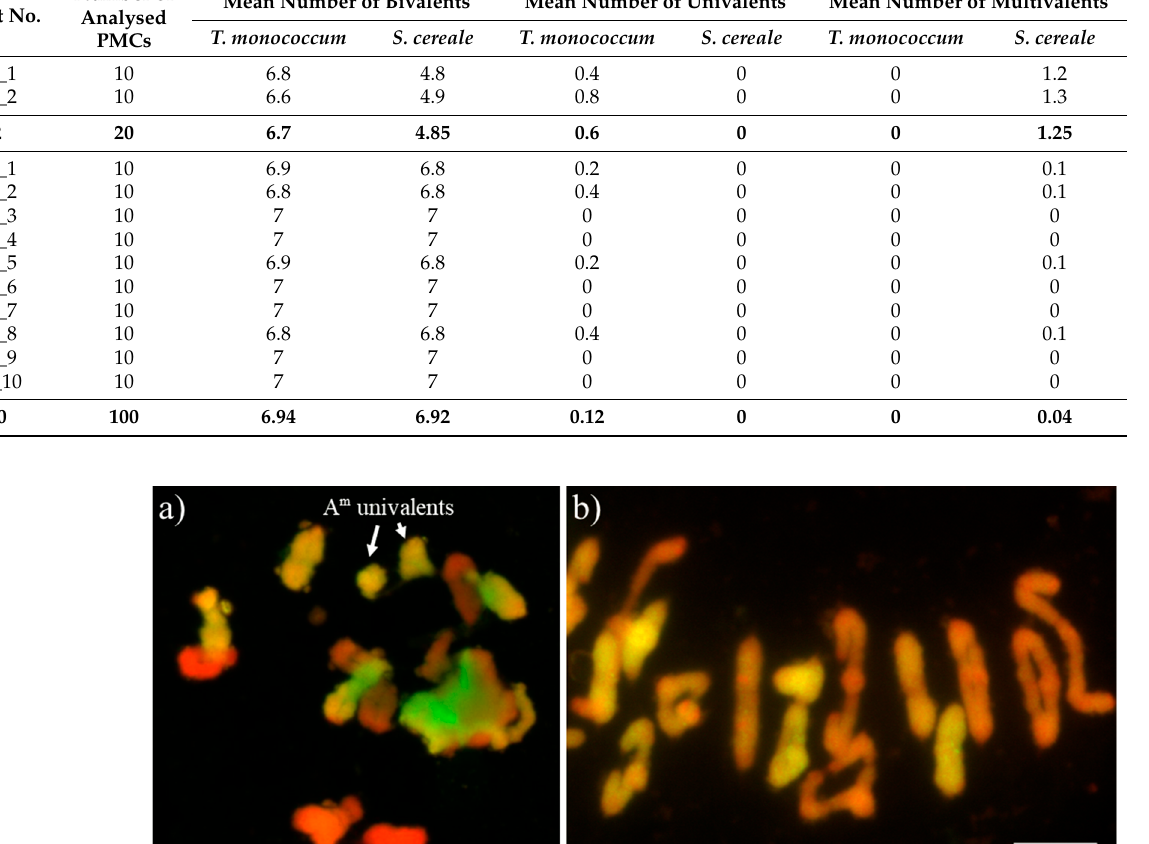
Table 5. Infection scores compared with PCR amplification products NL9F5 ( Sr35 ) marker. *, indi ‐ cates an allele which confers resistance.